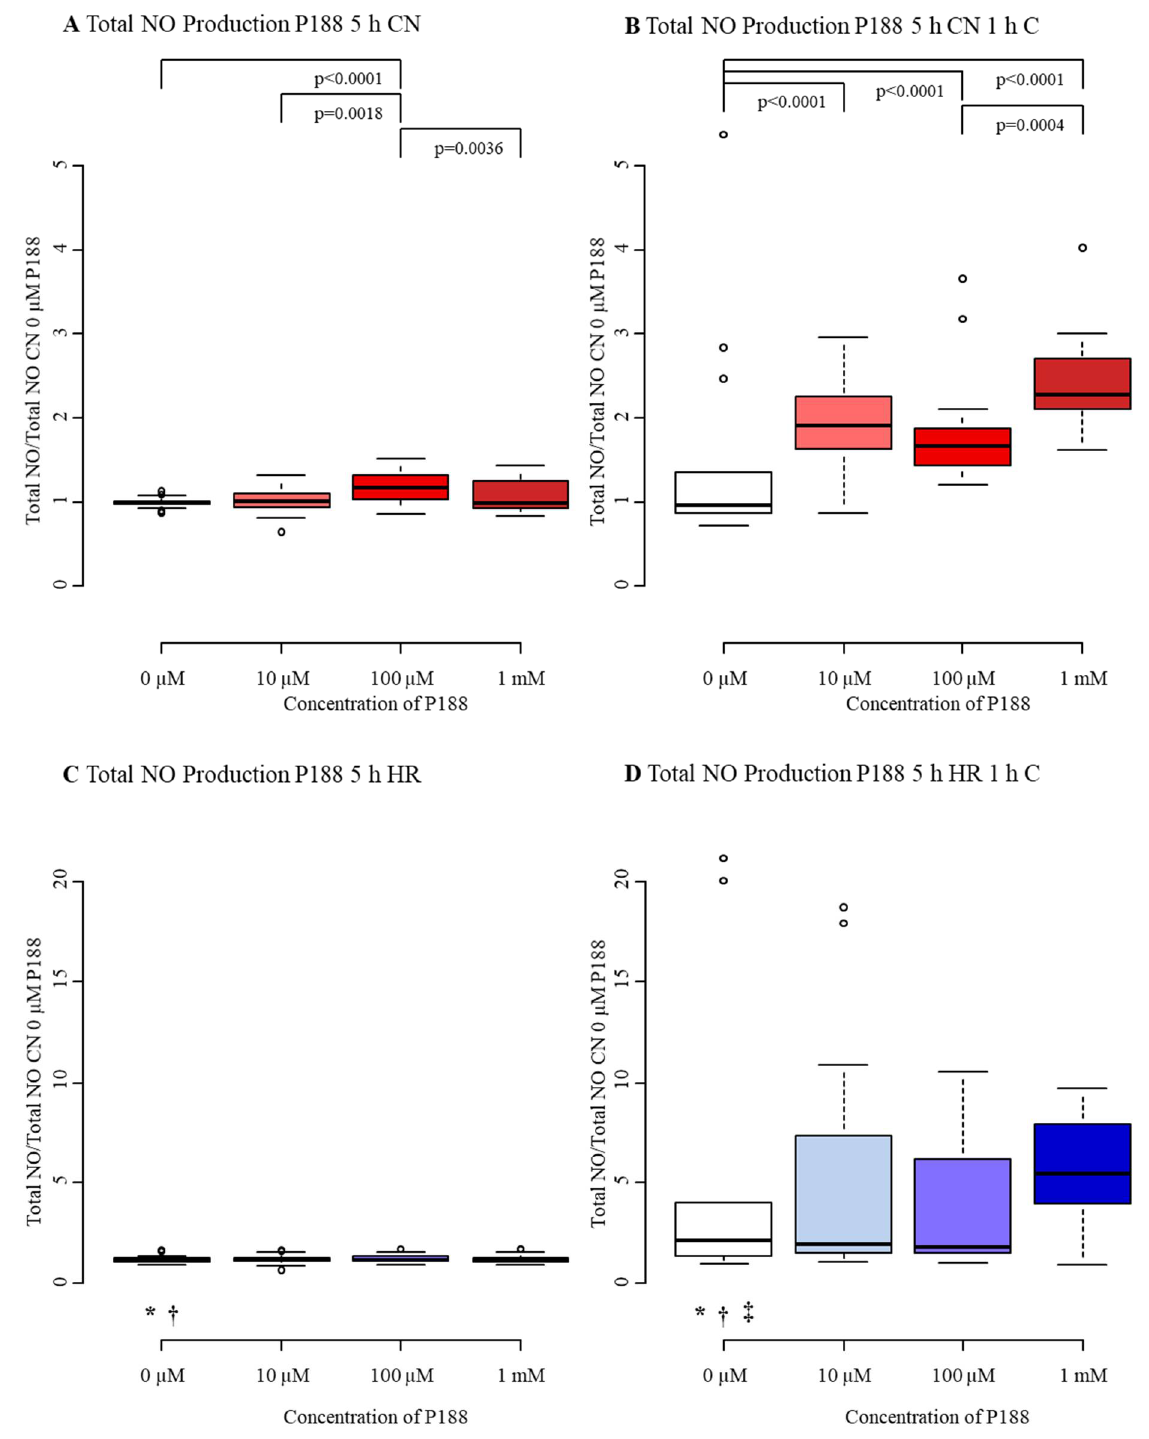
Figure 7. Total NO production after 5 h injury and treatment with 0 µ M, 10 µ M, 100 µ M, and 1 mM of P188. ( A ) normoxia (CN-C); ( B ) normoxia and 1 h compression (CN+C); ( C ) hypoxia (HR-C); ( D ) hypoxia and 1 h compression (HR+C), two potential outliers were not displayed for esthetic reasons. Data visualized as boxplots (median, 25th, 75th percentile, whiskers: minimum, maximum, dots: potential outliers); p < 0.05; n = 8–10 experiments/group. Significances between different concentrations of P188 are displayed as brackets, significances between A, B, C, and D for 0 µ M P188 are represented by symbols (* vs. CN-C 0 µ M P188, † vs. CN+C 0 µ M P188, ‡ vs. HR-C 0 µ M P188). Abbreviations: C, compression; CN, control/normoxia; h, hours; HR, hypoxia/reoxygenation; mM, millimolar; µ M, micromolar; NO, nitric oxide; P188, Poloxamer 188. Colors: red, normoxia; blue, hypoxia/reoxygenation. The shadows of red/blue represent the different concentrations of